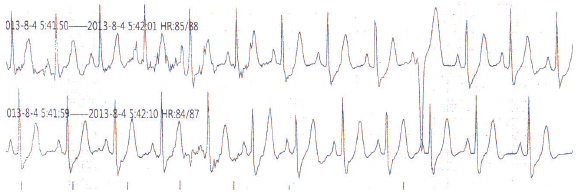
Figure 1: ECG record of 1 minute before attack at 5:41 a.m. on August 4, 2013.